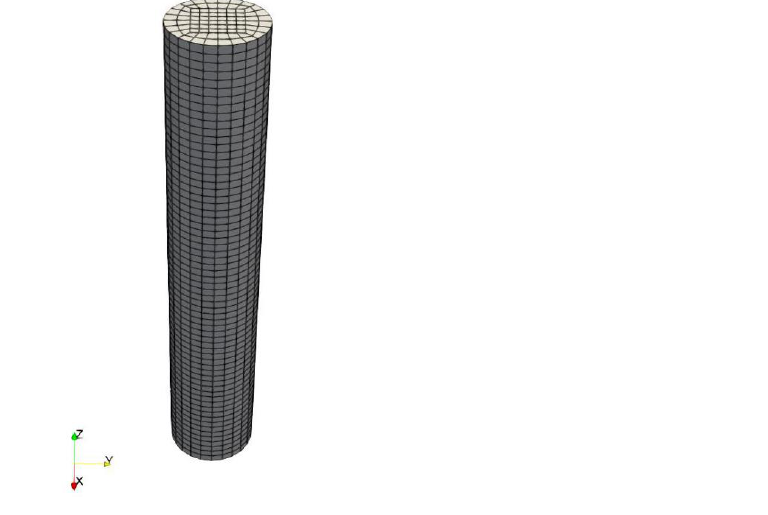
Figure 4. Schematic diagram of the packed bed geometry model and CFD grids. Table 2. Computational conditions and material